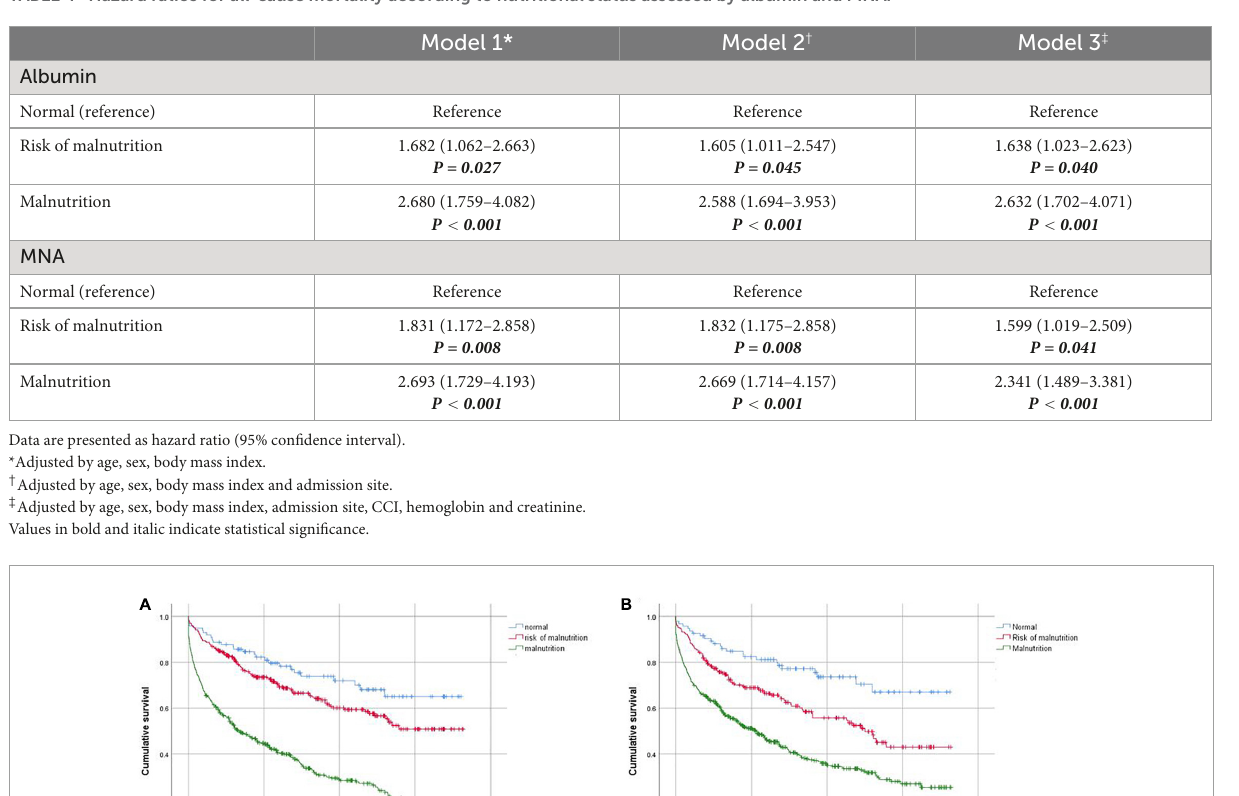
TABLE 4 Hazard ratios for all-cause mortality according to nutritional status assessed by albumin and MNA.